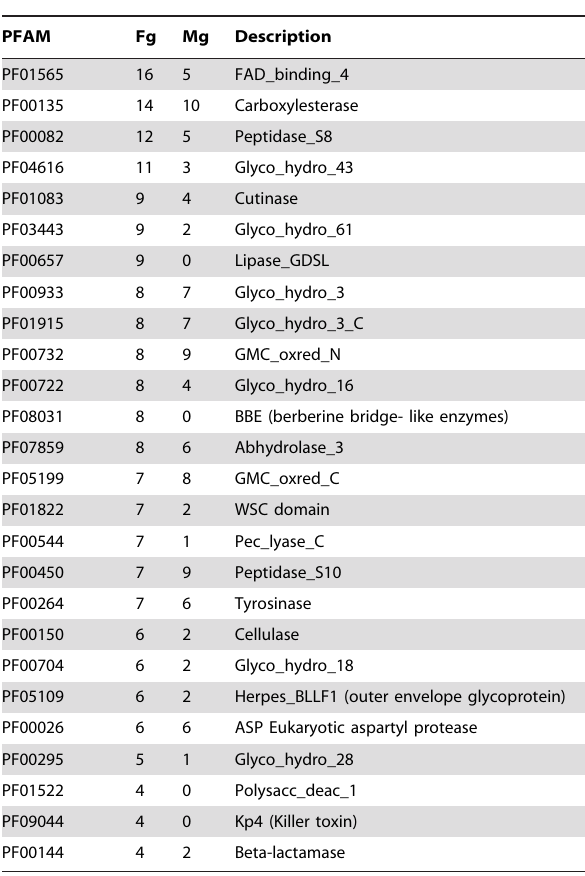
Table 8. Most frequent PFAM domains found throughout the secretome of Fusarium graminearum ( Fg ), and corresponding frequency in Mycosphaerella graminicola ( Mg